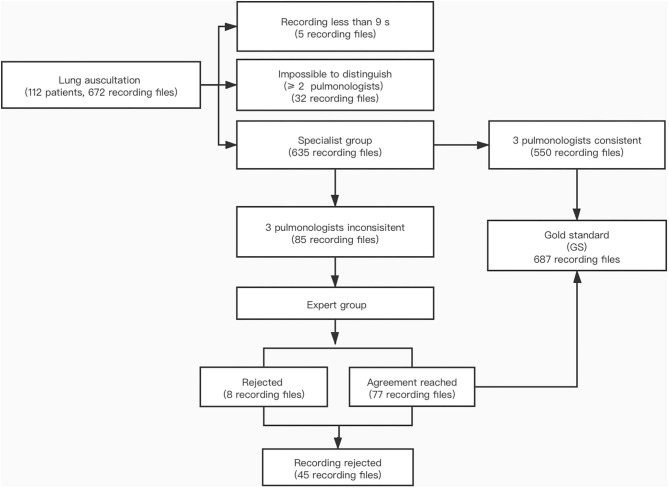
Flow chart of the establishment of the gold standard. Expert group: 2 pediatric pulmonologists with more than 20 years of work experience. Specialist group: 6 pediatric pulmonologists with at least 10 years of work experience.